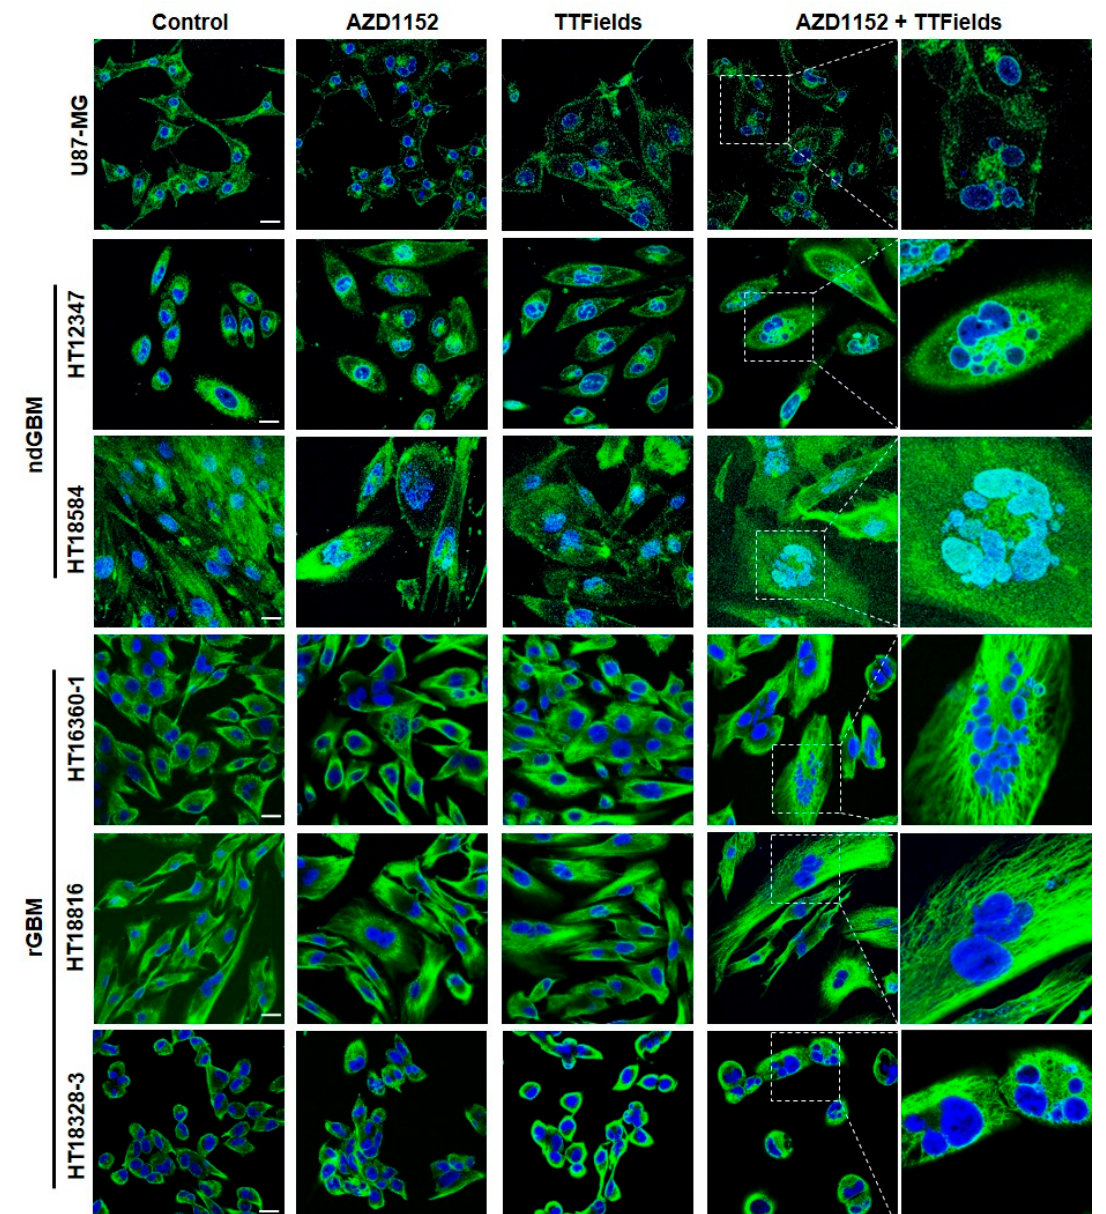
Figure 4. Morphological changes. Concomitant treatment of AZD1152 and TTFields enhances the morphological changes of the nucleus and cell shape in U87-MG and the primary glioblastoma cell cultures. Representative confocal laser scanning microscopic images after 72 h treatment with AZD1152 alone, TTFields alone, and AZD1152 plus TTFields are shown. Cell morphology was visualized in green with WGA (cell membrane staining, U87-MG and ndGBM) or anti- α -tubulin (cytoskeleton staining, rGBMs). DNA was stained with Hoechst 33342 (blue). The size scale in the control group corresponds to 25 µm.